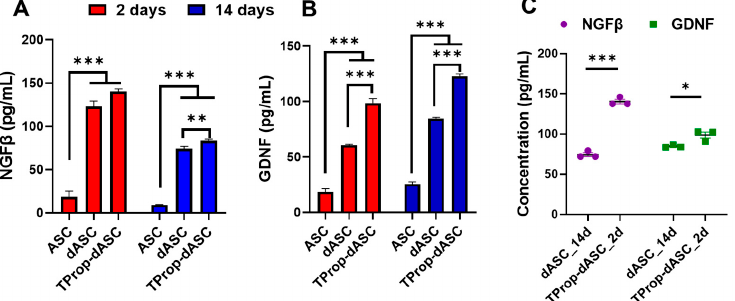
Figure 5. ELISA-based quantification of neurotrophic growth factors from ASC, dASC, and TProp-dASCs. Nerve growth factor (NGF β , ( A )) and glial-cell-derived neurotrophic factor (GDNF, ( B )) secretion levels at 2 days (red bars) and 14 days (blue bars). ( C ) Comparison of NGF β (purple circles) and GDNF (green squares) secretion between dASCs at 14 days and TProp-dASCs at 2 days. Both NGF β and GDNF levels were increased in TProp-dASCs as compared with dASCs at either day 2 or day 14 time points. Furthermore, the levels of both of these factors were higher with TProp stimulation on day 2 than without TProp stimulation on day 14. Data are expressed as mean ± SEM. * p < 0.05, ** p < 0.01, and *** p < 0.001, one-way ANOVA with Tukey’s post-test for ( A , B ), and Student’s t -test for ( C ).